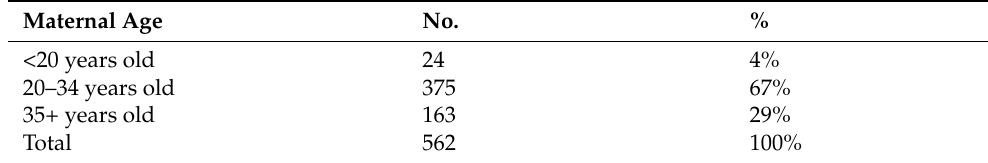
Table 2. Distribution of maternal age in the analyzed cohort.